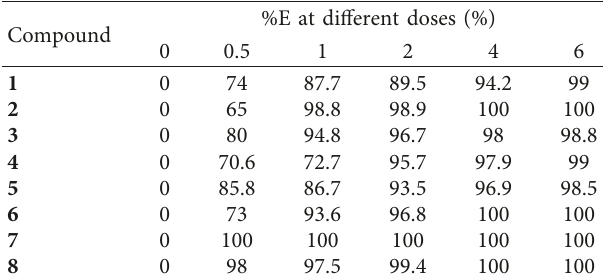
Table 3: The antioxidant efficiency (%E) of curcumin analogues 1–8 toward the LDPE oxidation.